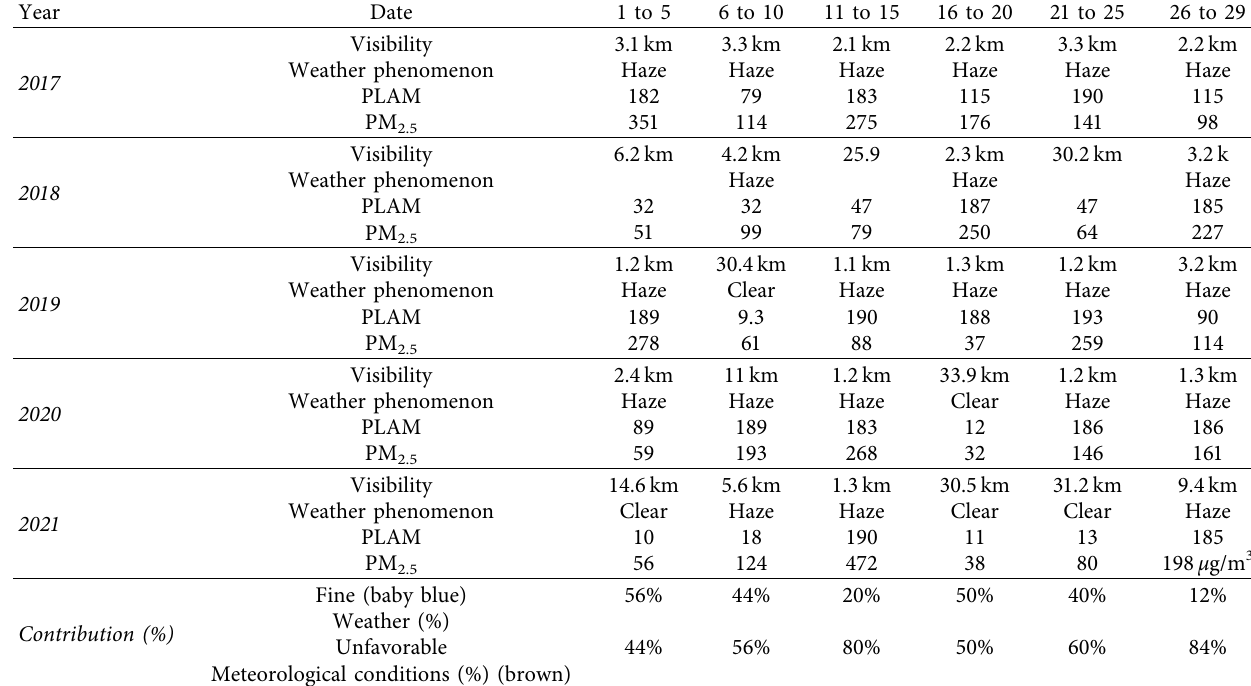
Table 5: Statistical analysis of the impact of meteorological conditions on air quality every 5 days during the same period of the Beijing for the years 2017 to